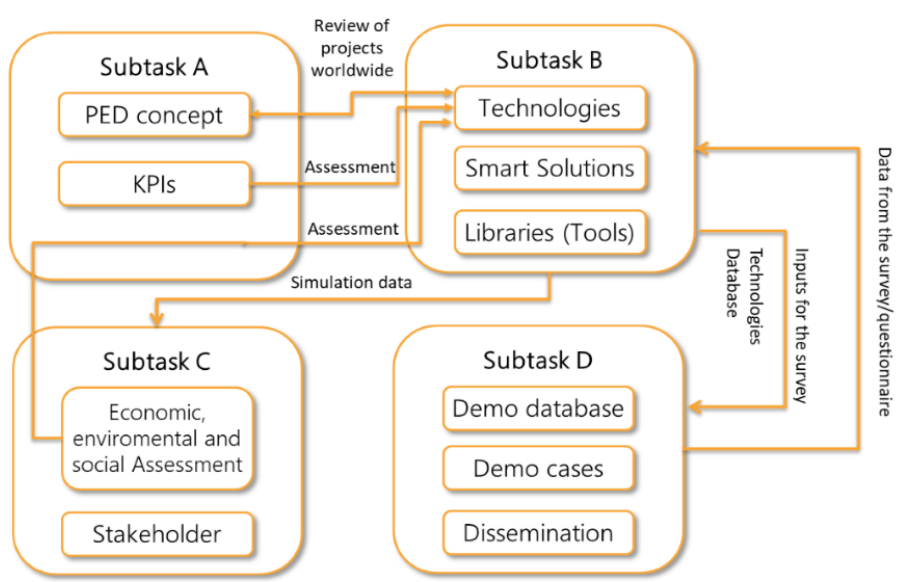
Figure 3. Subtask Figure 3. Subtask dependencies.